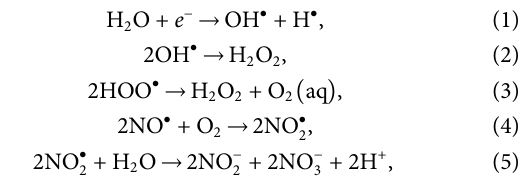
Frontiers in Physics |